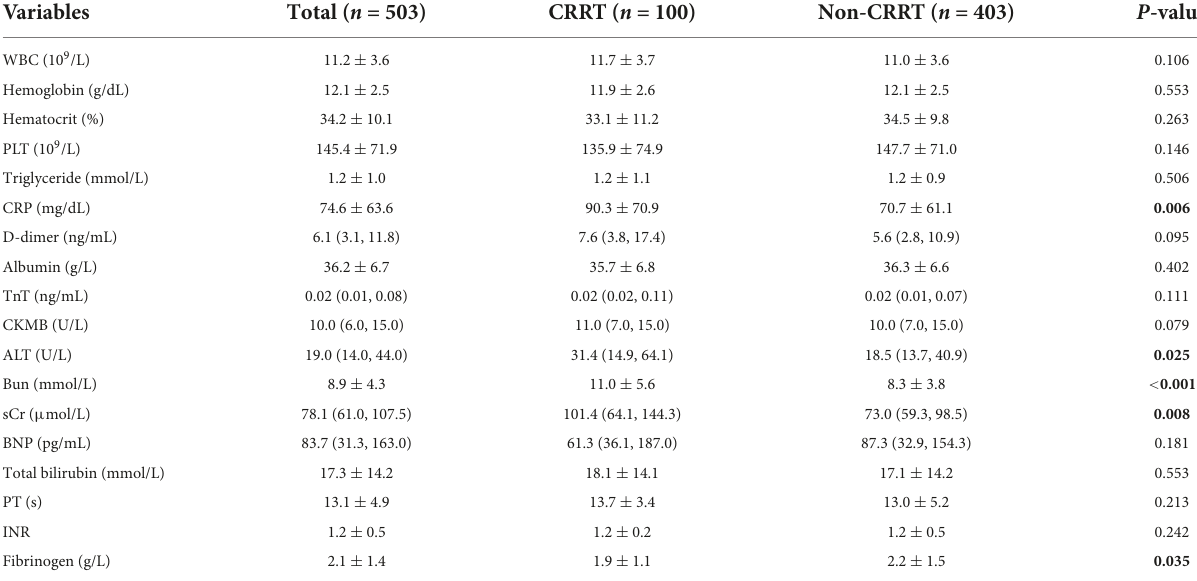
TABLE 2 Comparison of laboratory tests upon admission.